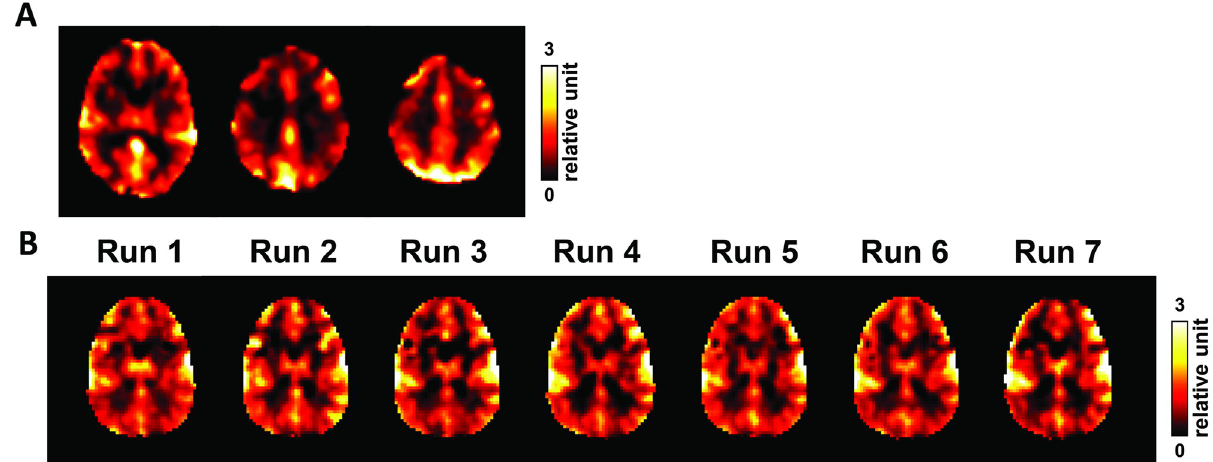
Fig 11. Examples of resting-state CVR maps. (A) CVR map from an healthy subject (28 years of age, male). BOLD imaging parameters were: TR/ TE = 2000/25ms, resolution = 3.4x3.4x3.5mm 3 , 154 dynamics. (B) CVR maps from repeated resting-state runs in a healthy subject (28 years of age, male). BOLD imaging parameters were: TR/TE = 1000/25ms, resolution = 3.4x3.4x5mm 3 , 300 dynamics.